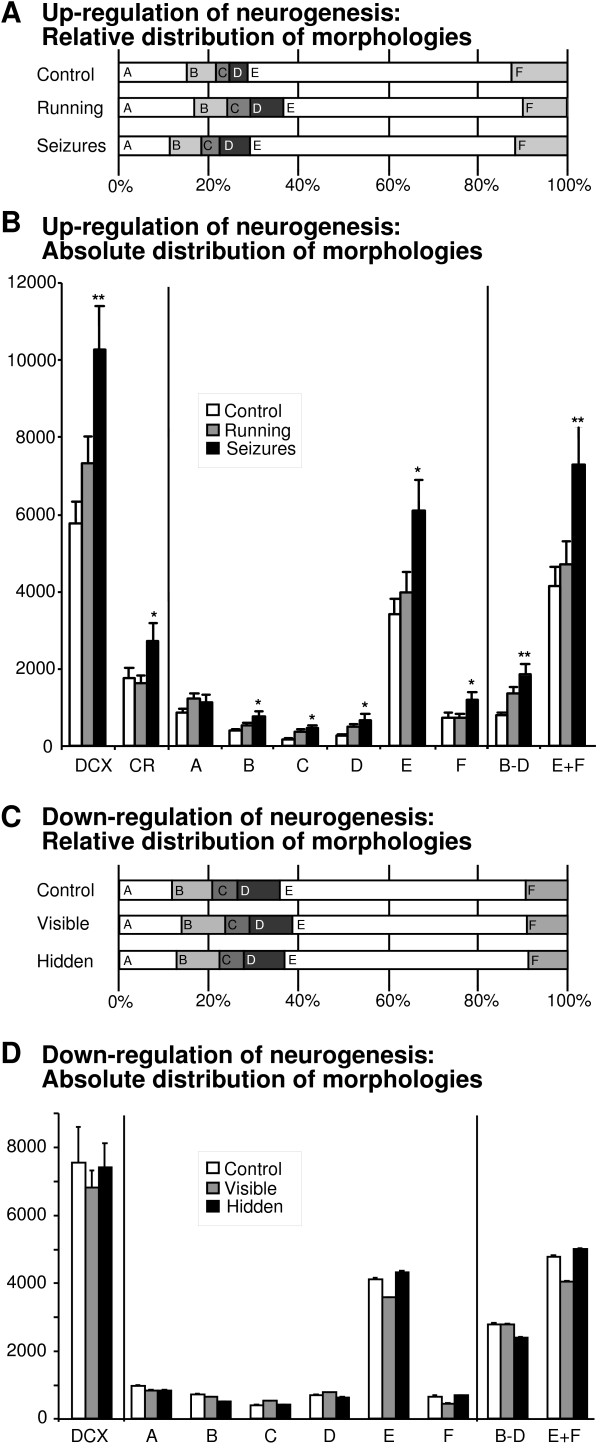
Distribution of dendritic morphologies among DCX-positive cells. A, among all DCX-positive cells of the SGZ, 22% are in categories A and B, the actively dividing stages (cf. Fig. 2). If categories C and D are included in this consideration the fraction of potentially proliferative DCX-positive cells is about one third (cf. Fig. 5). More than 50% of the DCX cells are in category E. If adult hippocampal neurogenesis is increased by voluntary wheel running or kainic acid-induced seizures, at the peak of cell proliferation the distribution of DCX-positive cells is not changed compared to control conditions. B depicts the absolute numbers. Across the categories there is an increase in cell numbers. C, stress associated with swimming in the Morris water maze was found downregulate adult neurogenesis and affected dividing precursor cells [44]. Analysis of dendritic morphology of DCX-positive cells from that study revealed again no change in the distribution of dendritic morphologies. D shows the absolute values.